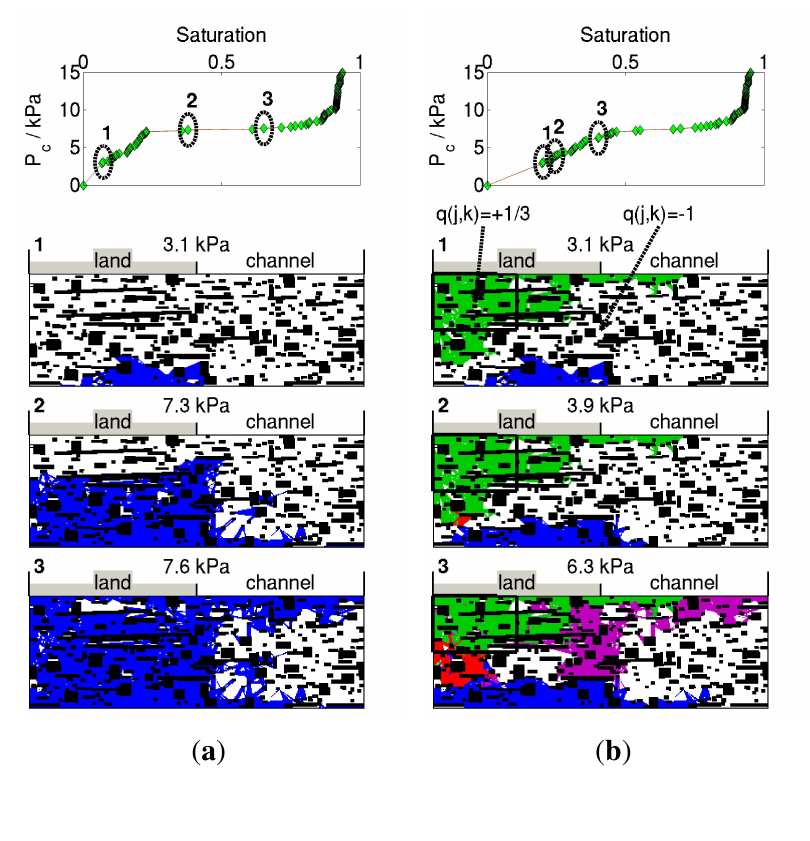
Figure 8. Capillary pressure-saturation curve and saturation distribution for three pressure levels during the injection process (injection is from the bottom interface), ( a ) without and ( b ) with condensation using the same GDL model. For the condensation simulation ( b ), the saturation distribution at the same pressure level is compared to the distribution without condensation, and the water filled regions are colorized according to the different filling processes—green: by condensation only; blue: by injection without condensation; red: by both the condensation and the injection without condensation; purple: by injection with condensation. The model is generated using the parameters for a Toray TGP-H-120 with 10 wt% PTFE from Table